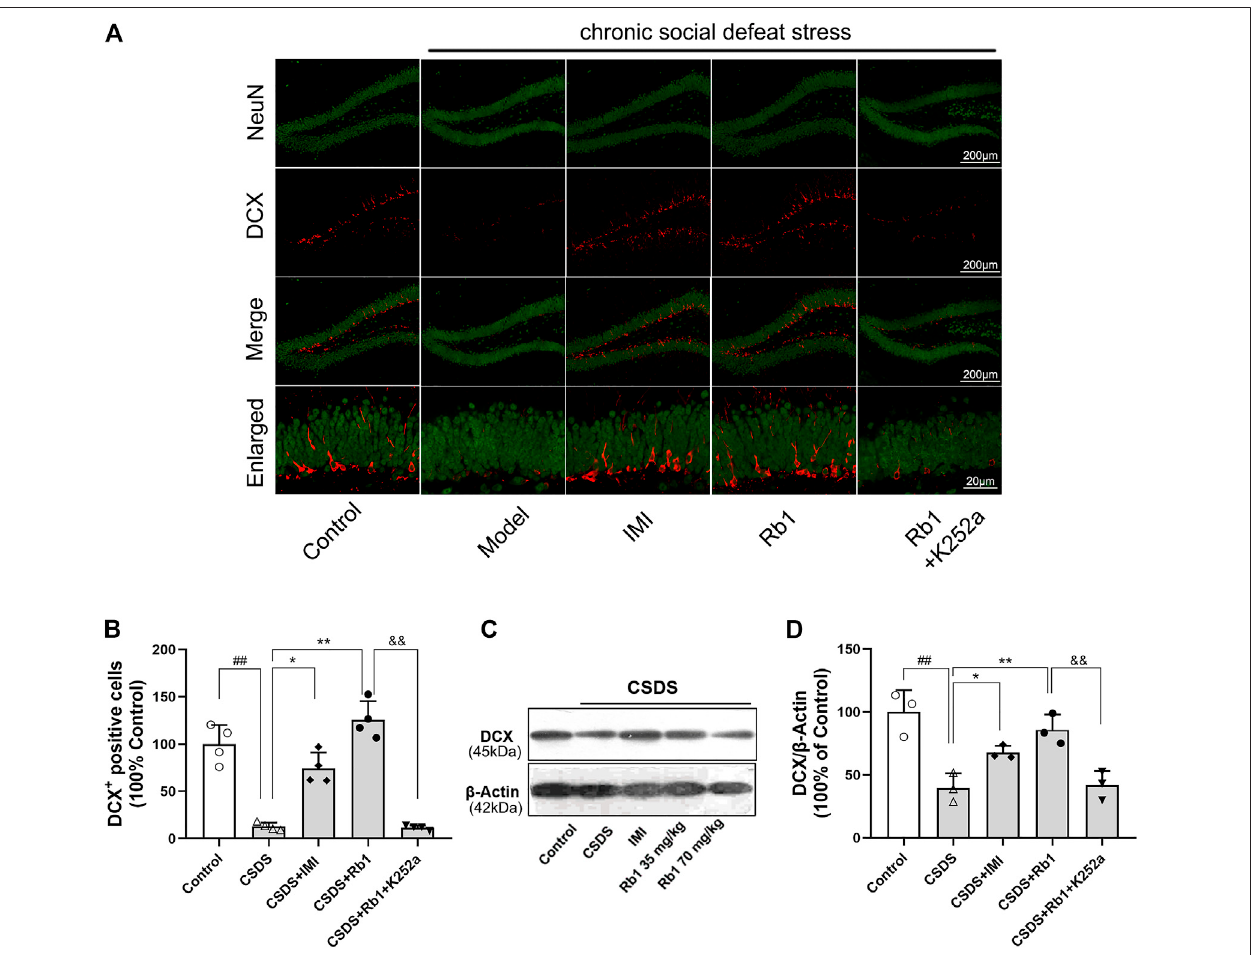
FIGURE 6 | Impact of pretreatment with K252a on the number of DCX-positive cells (Rb1-induced) in CSDS. (A) Representative immuno fl uorescence images of the dentate gyrus (DG) and costaining of the neuronal nuclear protein (NeuN) and DCX in green color. The scale bar is 200 and 20 μ m for the representative and the enlarged images, accordingly. (B) The number of DCX + cells in the DG. (C – D) Represents immunoblotting of DCX coincided with immunohistochemical changes. N (cid:2) 3 – 4 per group; the obtained data have been depicted as mean ± S.E.M. # p < 0.05, ## p < 0.01, vs. the control group; * p < 0.05, ** p < 0.01, vs. the model